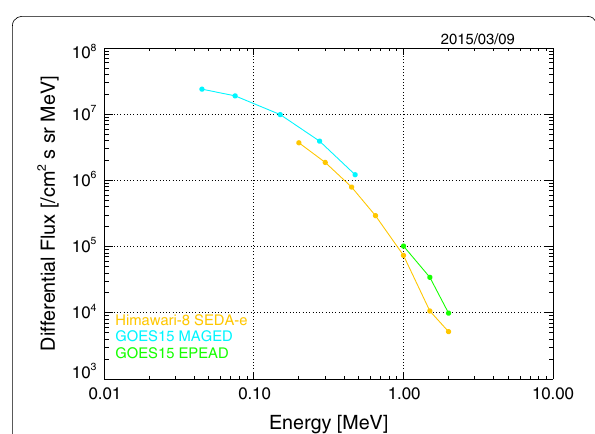
Fig. 8 Combined proton differential flux spectra from Himawari-8/ SEDA ( red ), GOES-13/EPEAD ( black ) and GOES-13/EPEAD with effec- tive energy ( green ) at 10:45 UT on Oct. 29,